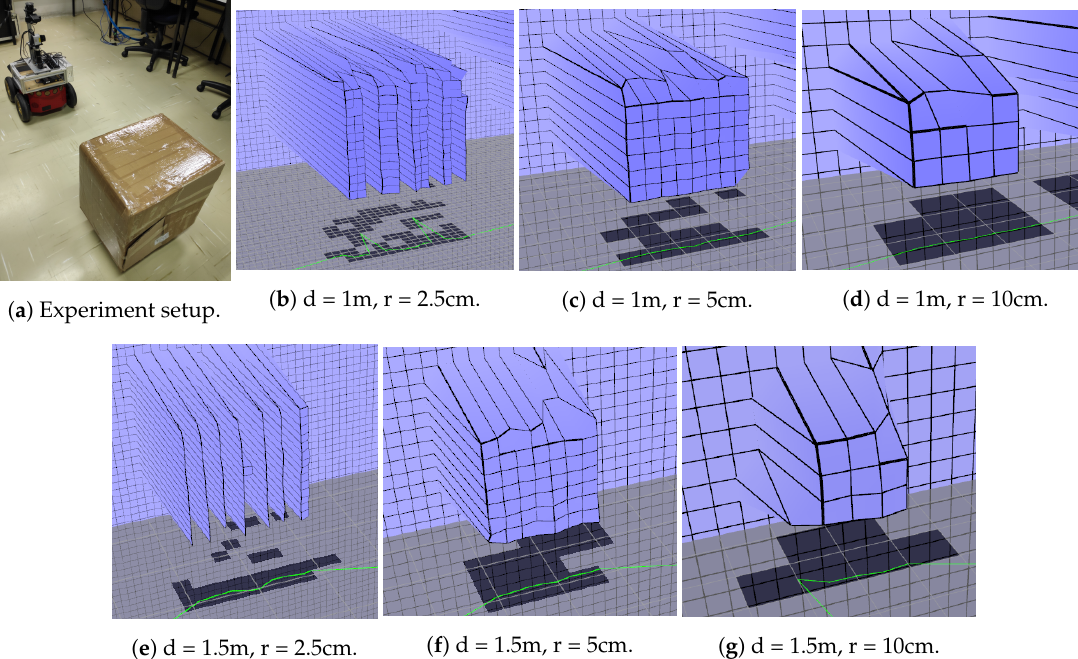
Figure 18. Box distance measurement experiment showing the experiment setup (Figure 18a), scans of the box with different values of distance (d = 1 m and 1.5 m) and local map resolution (r = 2.5 cm, 5 cm and 10 cm). The black squares represent the box on the global map. The green line represents the sight